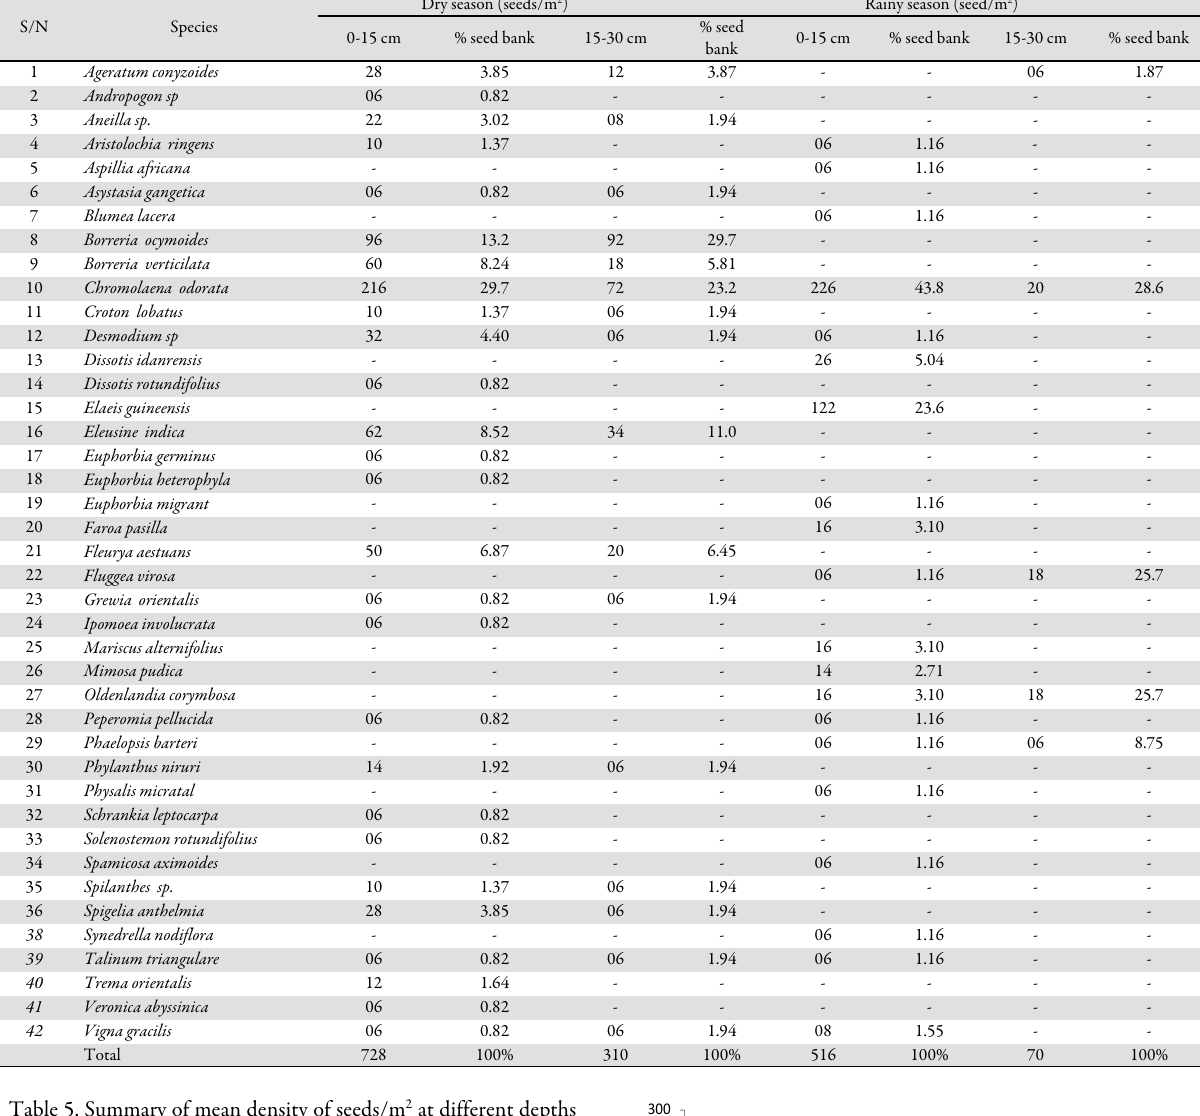
Table 4. Mean density (seeds/m 2 ) and percentage contribution of each species in the seed bank of upland vegetation in both dry and rainy season at 0-15 cm and 15-30 cm depth S/N